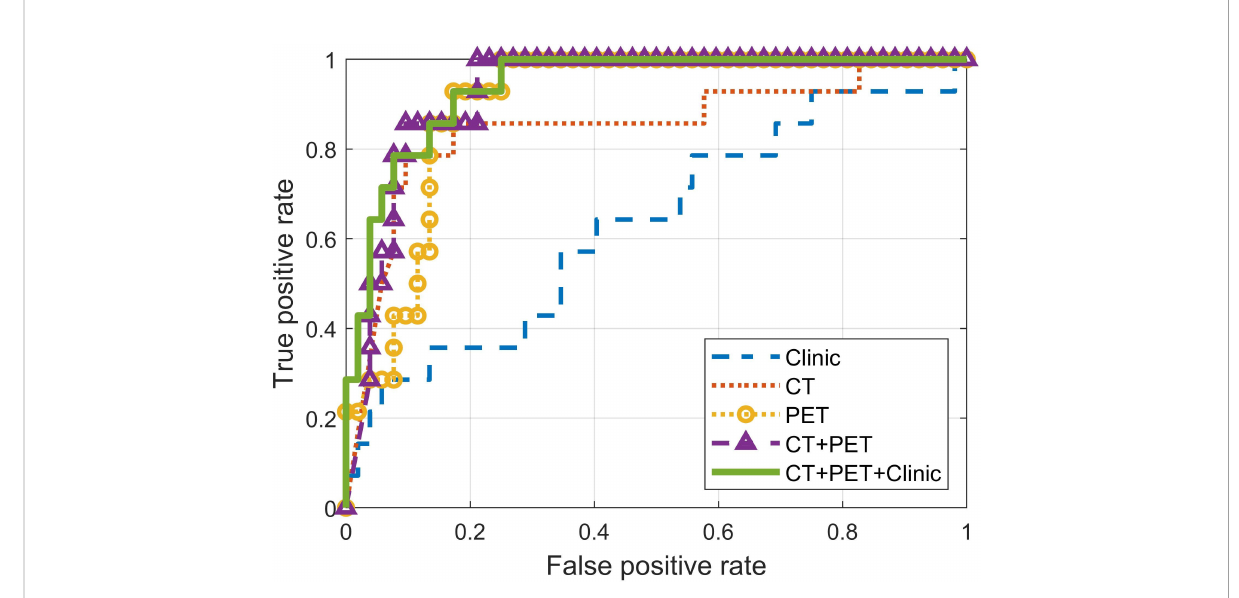
FIGURE 4 Receiver operating characteristic (ROC) curves of models built with features from different